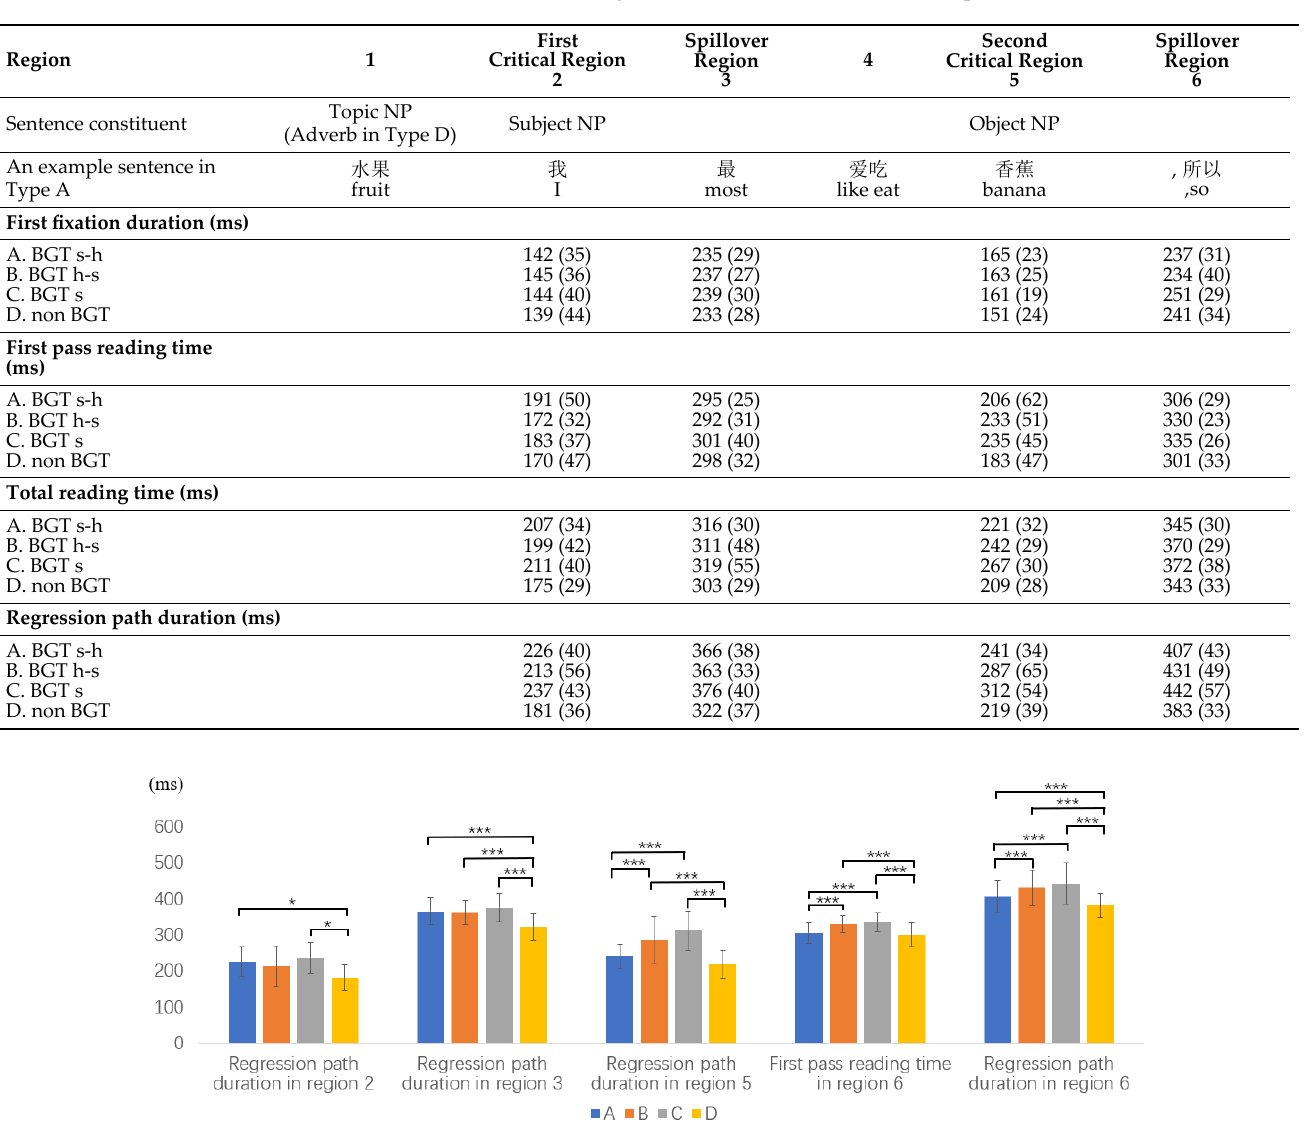
Figure 1. Part of representative reading measures for native Chinese speakers (* p < 0.05, *** p < 0.001). Table 3. Means (SD) of reading measures for the native Chinese speakers.